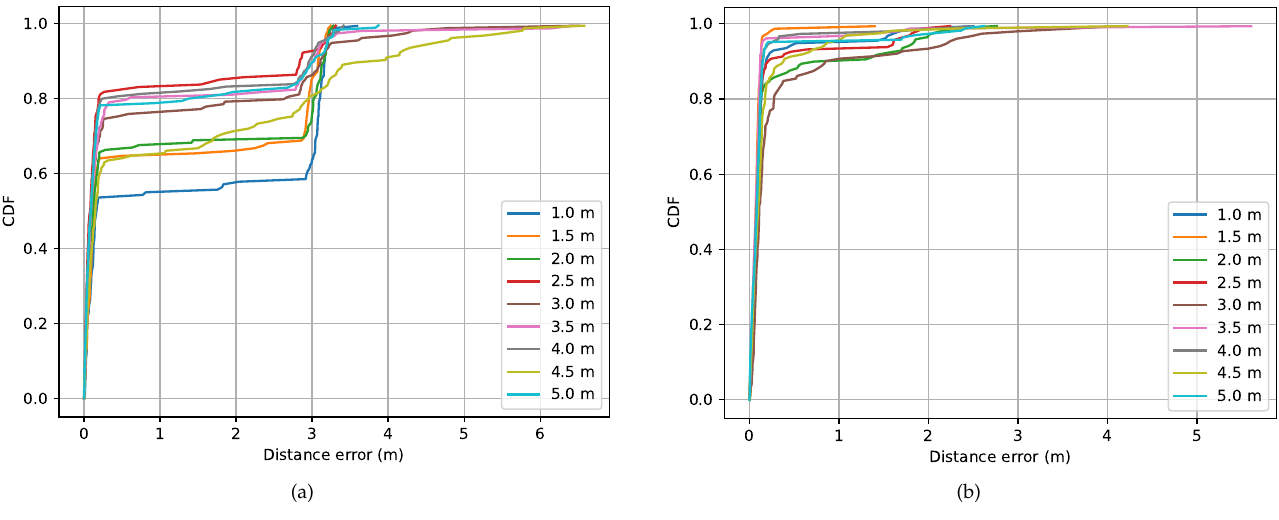
Figure 12. ( a ) CDF plot of the measured distance error for ∆ x a = 300cm and different ∆ x rf ; and ( b ) the fixed acoustic distance is here ∆ x a =